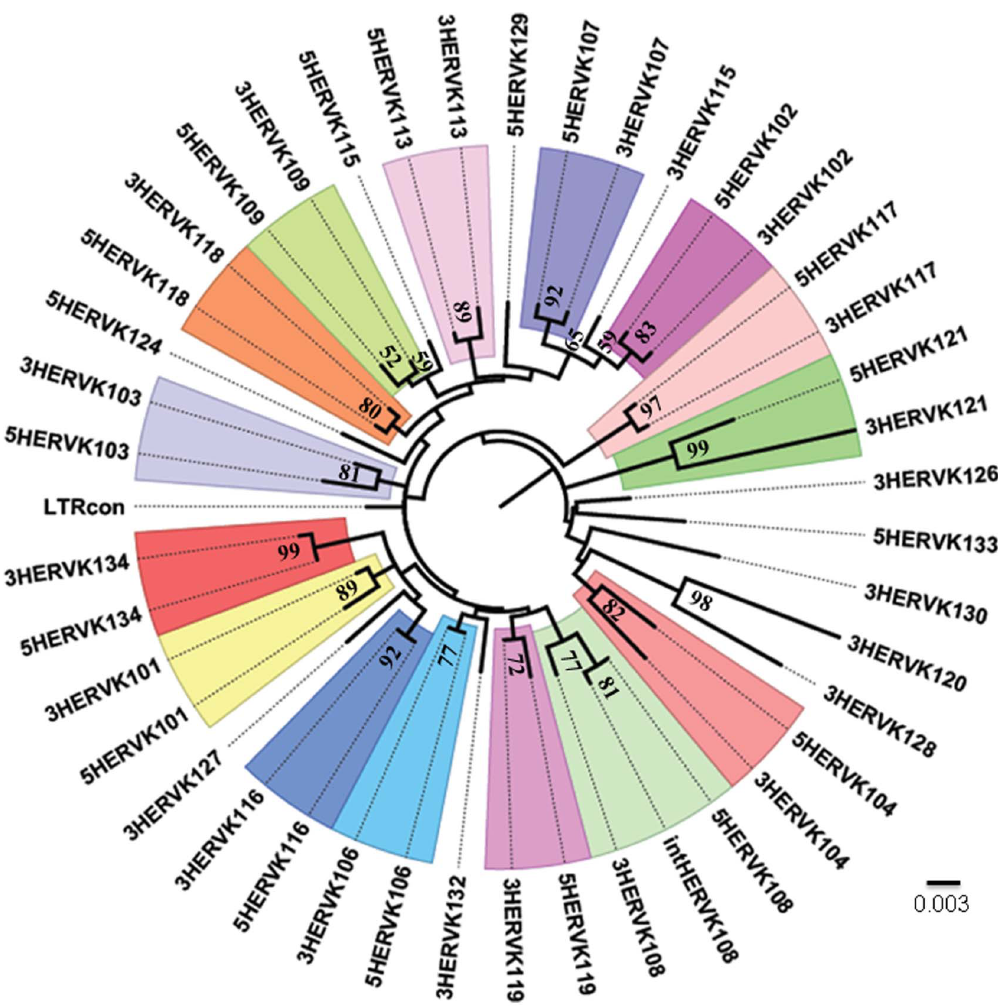
Figure 2. The phylogenetic tree of human-specific HERV-K LTRs. This is a maximum likelihood tree reconstructed using Kimura-2-parameter distance model. Most HERV-K elements contain an LTR at their 5 9 and 3 9 ends. In cases where the two LTR sequences are similar to one another, they are shown in the same colour. LTRs from the same element but having divergent sequences are not clustered in the same colour. Short LTRs causing ambiguity on this tree were excluded from this analysis. Bootstrap values for nodes (% of 1000 replicates) scoring higher than 50% are